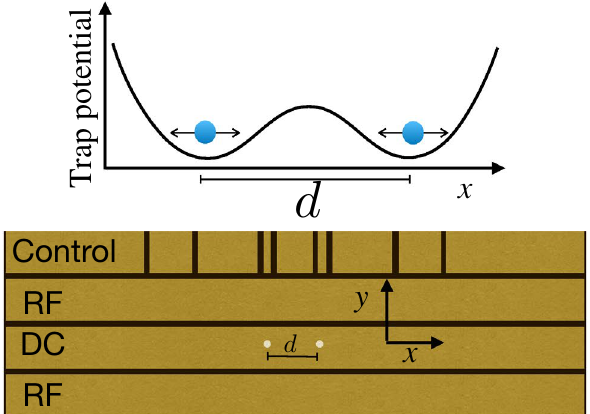
Figure 1. Scheme of two interacting trapped ions with the same charge q . Each ion is confined in a potential well along of coordinate x and separated by a distance d . Schematic diagram based on Ref. 37 , where the trap electrodes are placed in a single plane of a chip-based trap 46 . The RF and DC electrodes are placed to form a pseudopotential minimum above the surface, with the longitudinal confinement and multiple regions of confinement guaranteed by DC end caps, alternating with RF voltages, as depicted by the Control